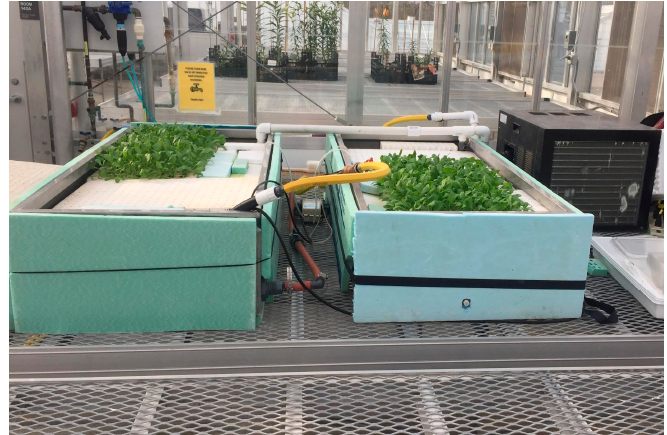
Figure 2. Bench-scale deep-water culture (DWC) system at half-capacity.